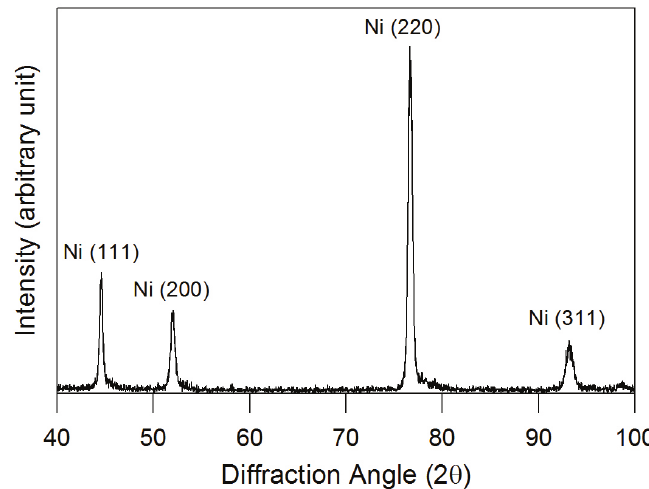
Figure 3. X-ray diffraction patterns XRD pattern obtained from pulse deposited Ni showing (220) preferred orientation.